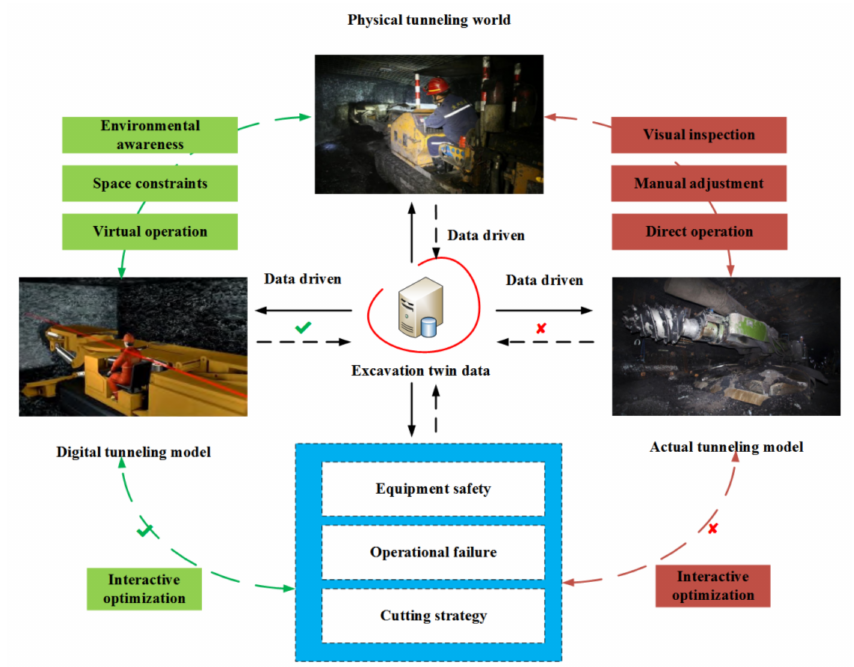
Figure 1. Digital twin conceptual model of tunneling